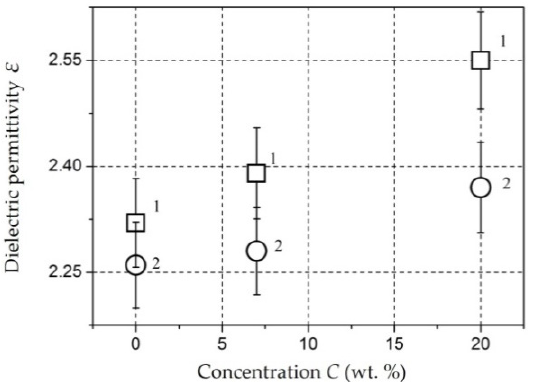
Figure 9. The dependence of the permittivity ε of composite nanomaterial on the mass concentration of Mo in HPPE: 1, at a frequency of 1 kHz; 2, at a frequency of 1 MHz. Adapted from [146] with permission. Table 4. Results of measurements of ε Pb-containing composites at frequencies of 1 kHz and 1 MHz.